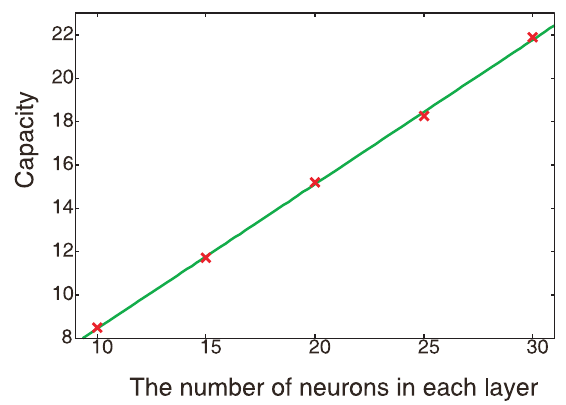
Figure 6. Capacity dependence on N. Capacities for various numbers of neurons N are plotted. Each capacity is measured after learning the maximum number of I/O mappings (i.e., the number of neurons in each layer N ). The time scales are t FS ~ 64 and t BS ~ 16 , which is independent of N , while T mem , r , E are in proportion to 1 = N .